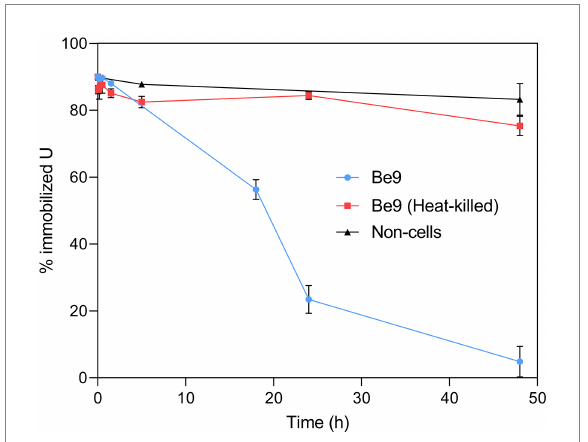
FIGURE 7 Uranium solubilization kinetics assay (%) during the incubation of Microbacterium sp. Be9 cells with U-phosphate precipitates. Flasks without cells and including heat-killed bacterial cells were used as control treatments. Data are shown as the mean and the error bars represent the standard error of at least three independent